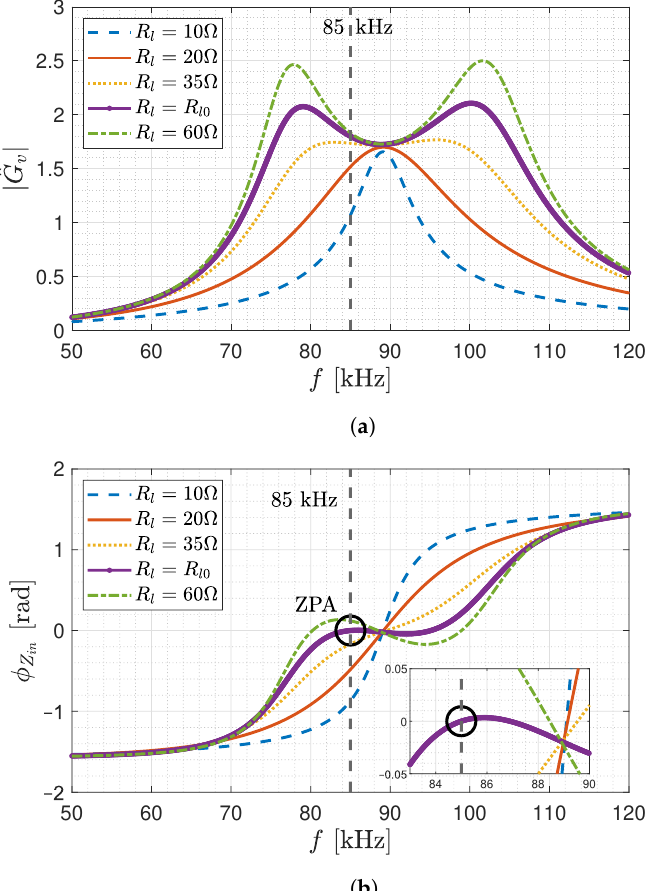
Figure 5. ( a ) Voltage gain magnitude and ( b ) input impedance angle as a function of the frequency for the inductive link designed for coupling independent ZPA operations at f 0 = 85